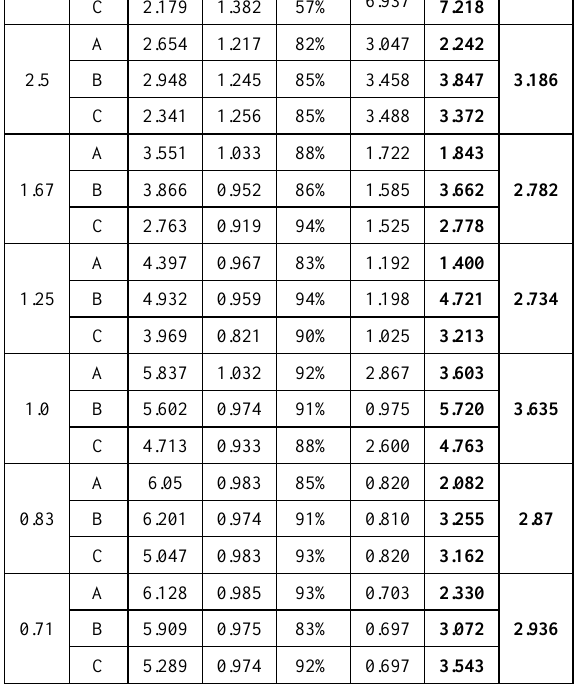
Table 4. Measurement of GCP Chip matching performance of RapidEye image by GSD